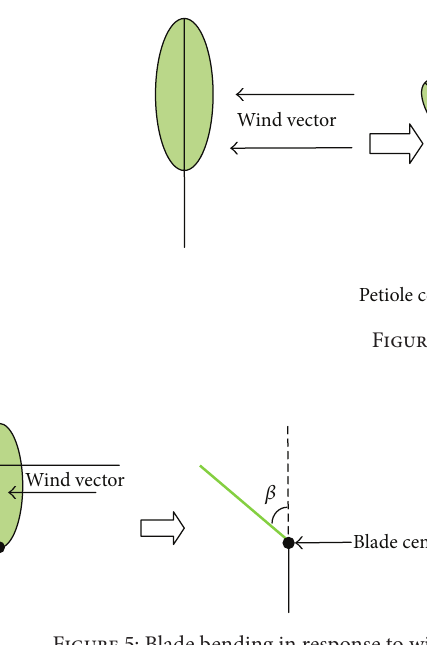
Figure 5: Blade bending in response to